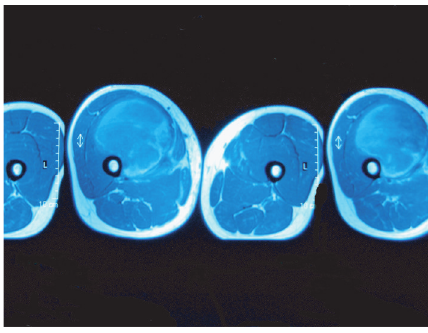
Figure 1: T1-weighted axial spin-echo pulse sequence. Huge mass seen in the right anterior thigh. Peripheral high signal is in keeping with methaemoglobin.